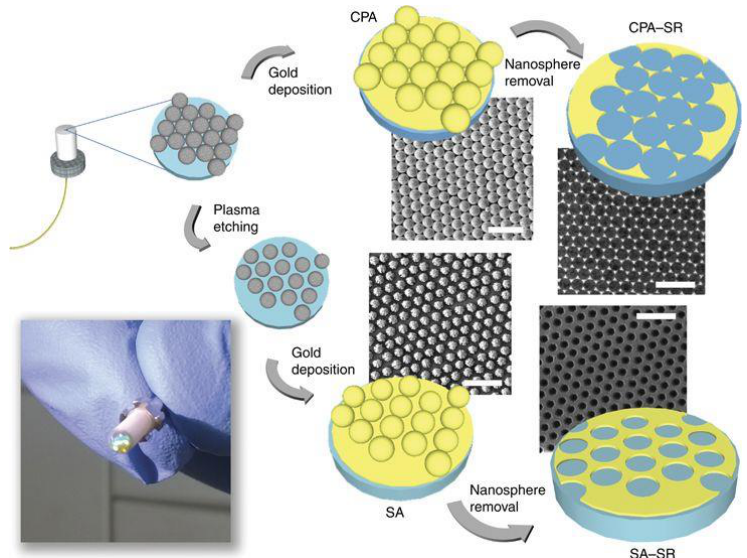
Figure 2. Schematic illustrating the nanosphere lithography of the fiber tip and SEM images (scale bar = 3 μm) for real samples obtained using 1-μm nanospheres corresponding to different geometric features—closely packed arrays (CPA), sparse arrays (SA), and CPA and SA sphere removal (SR). A